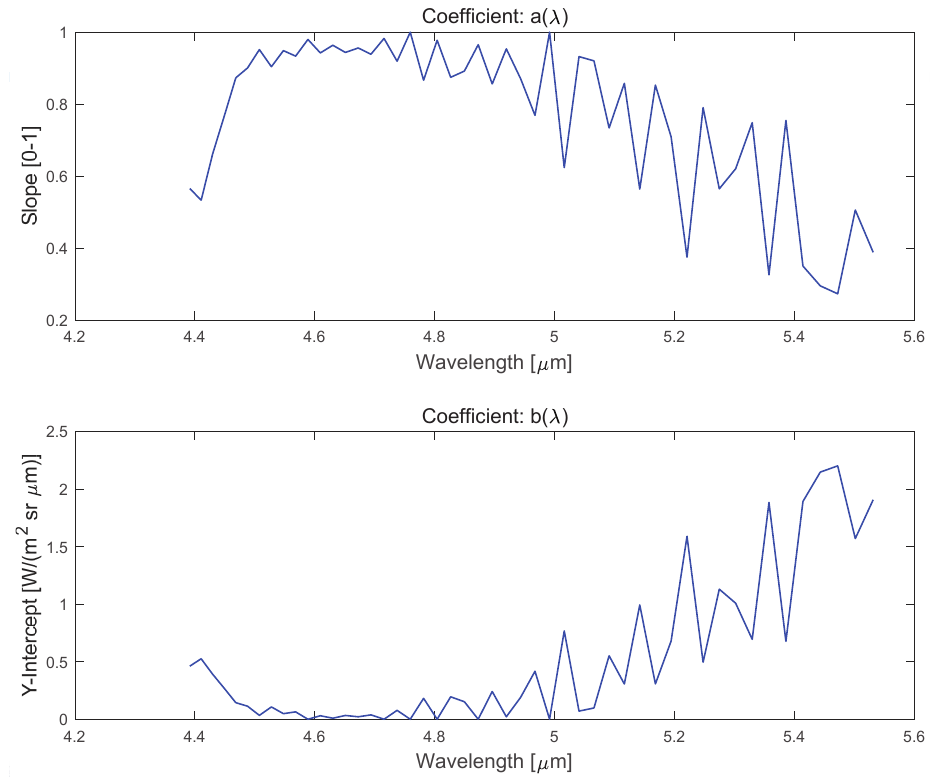
Figure 12. Examples of slope a ( λ ) and y-intercept b ( λ ) coefficients in linear regression. τ ( λ ) separation module: As a result that b ( λ ) = ( 1 − τ ( λ )) L BB ( λ , T air ) , atmospheric transmittance τ ( λ ) can be calculated using b ( λ ) and L BB ( λ , T air ) as follows: